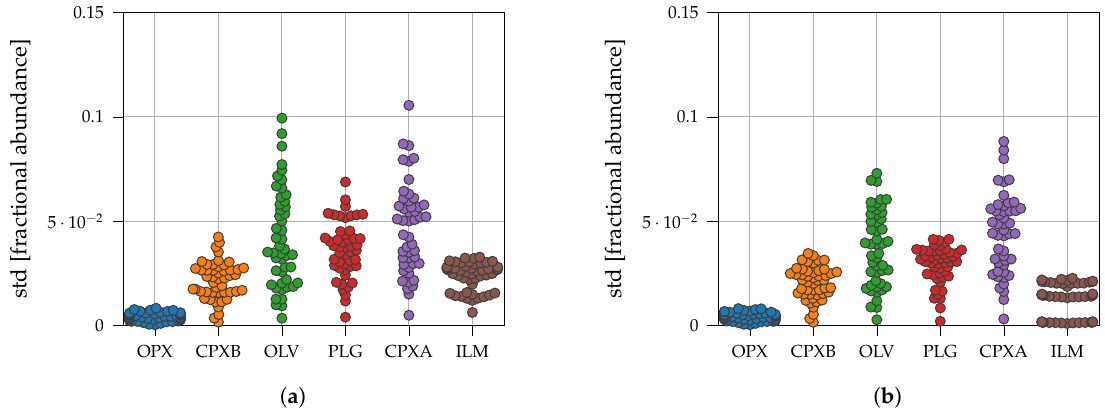
Figure 12. Uncertainties associated with each of the mineral abundances. With a prior all uncertainties, except for the orthopyroxene, which is already quite low, can be reduced. Each circle represents one mixture. ( a ) Without prior; ( b ) TiO 2 and Al 2 O 3 prior.